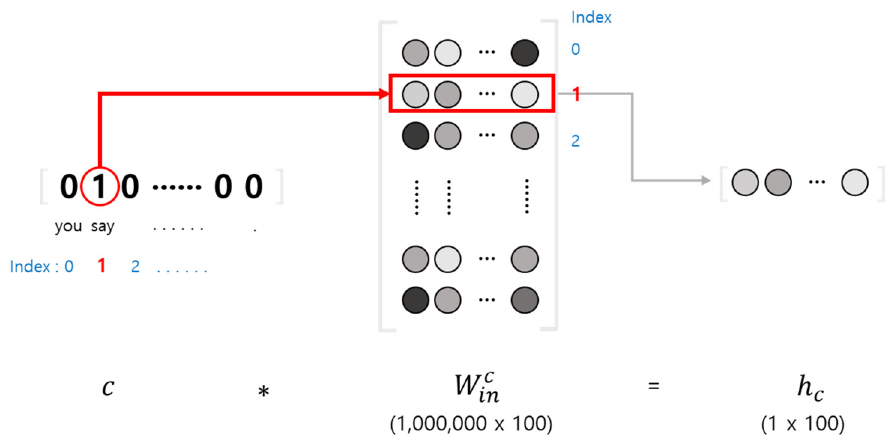
Figure 6. Word embedding layer.